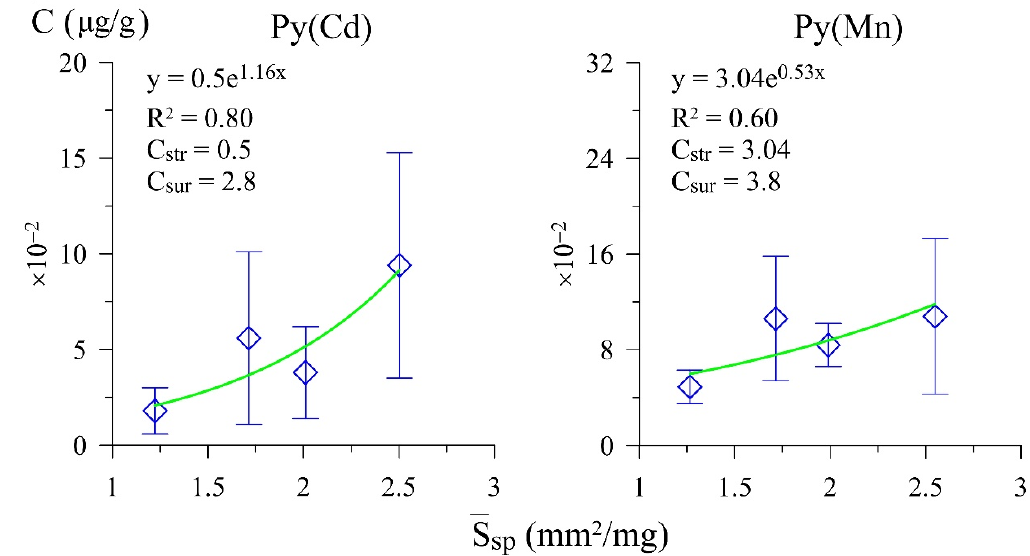
Figure 3. Dependence of the average concentrations of evenly distributed Cd and Mn in pyrite on the specific surface area of an average crystal of crystal-size fractions. See Figure 2 for explanations. Table 2. Ag, Pd, Cd, and Mn contents and distribution coefficients (in terms of weight and atomic values) in the pair pyrite–pyrrhotite at 400 ◦ C and 1 kbar from the data of AAS–ADSSC